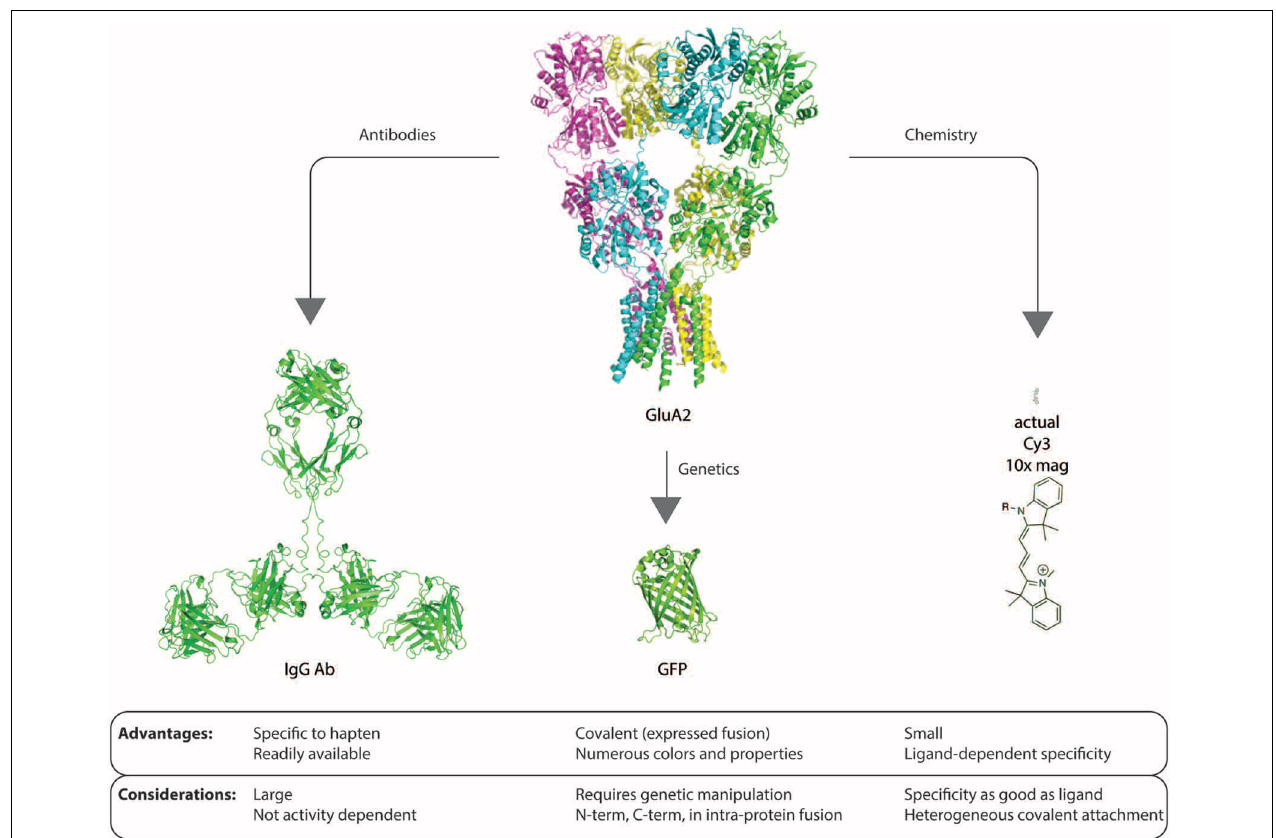
FIGURE 1 | Graphic example of advantages and considerations of each method of contrast agent delivery to proteins of interest. The size scale of the glutamate receptor GluA2 structure [PDB: 3KG2 (Sobolevsky et al., 2009)], IgG (Clark, 1997), GFP [PDB: 1GFL (Yang